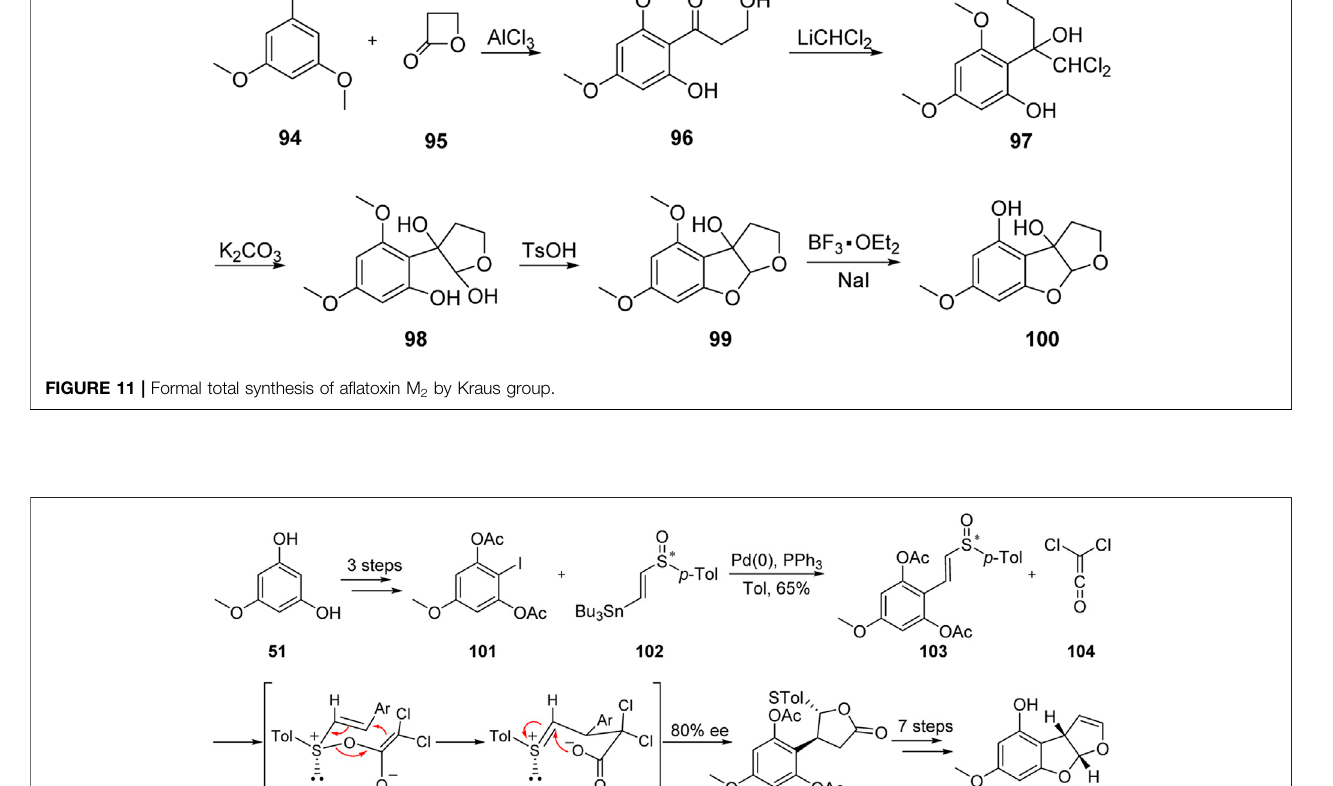
1 by Marino group.